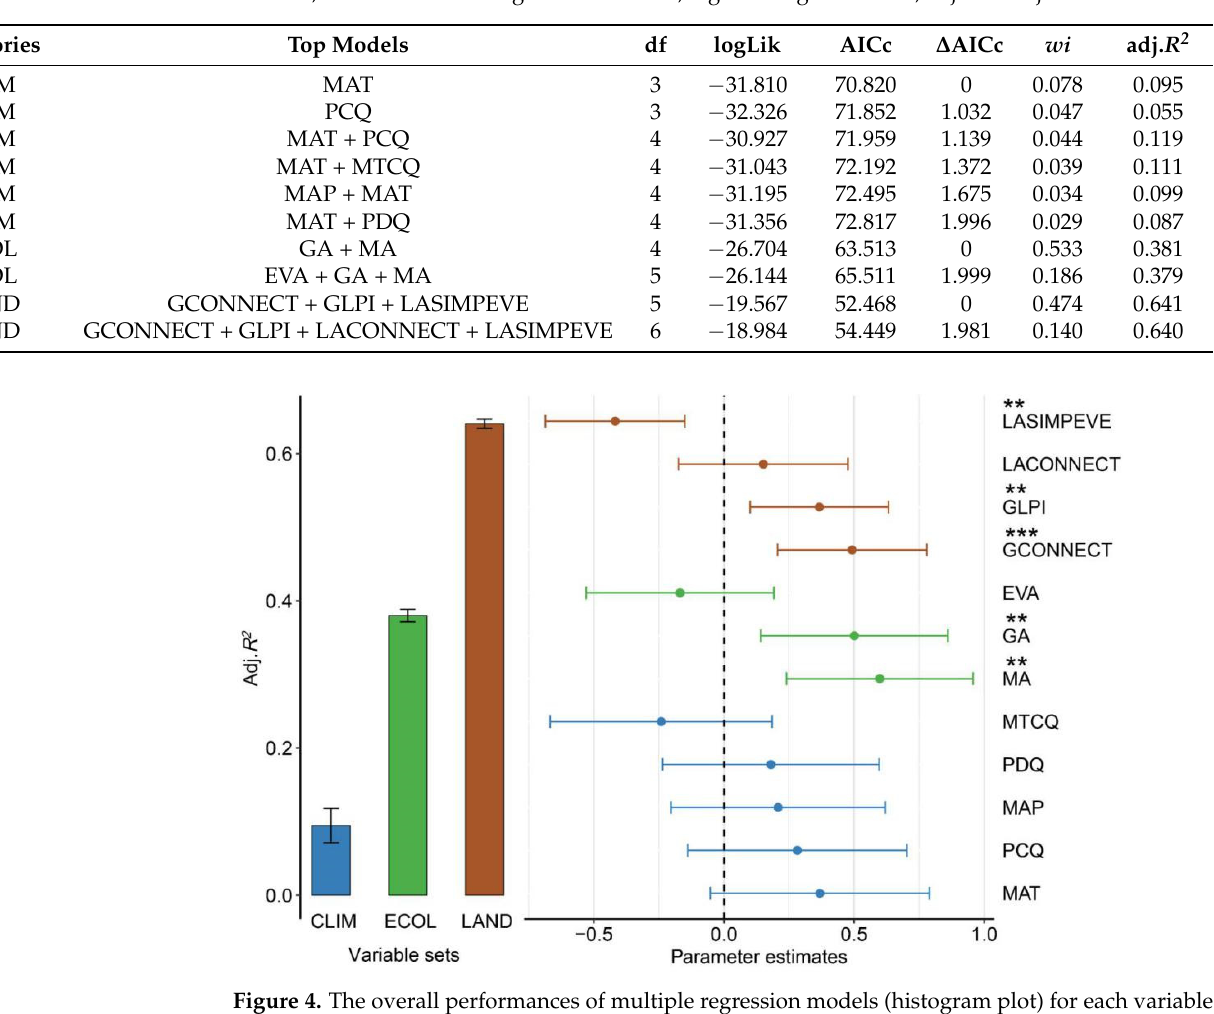
Table 3. Variables of each category featured in the best models, explaining the Greater White-Fronted Goose population trend in order of increasing AICc (Akaike information criterion for small sample size), ∆ AICc, and wi (Akaike weights) based on the multiple linear regression models. CLIM = climate factors; ECOL = ecological factors; LAND = landscape factors. For variables’ abbreviations, see Table 1. df = degrees of freedom, logLik = log likelihood, adj. R 2 = adjusted R 2 .